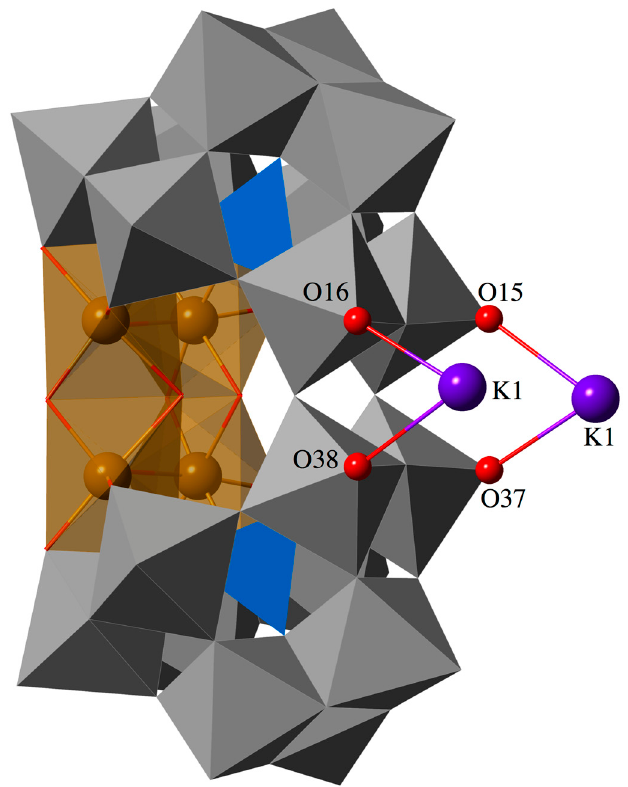
Figure 3. Interactions with K + ions of the terminal oxygen atoms of the WO 6 polyhedra serving as a hinge between the two trilacunary β -Keggin units of β , β -Fe 4 -open .